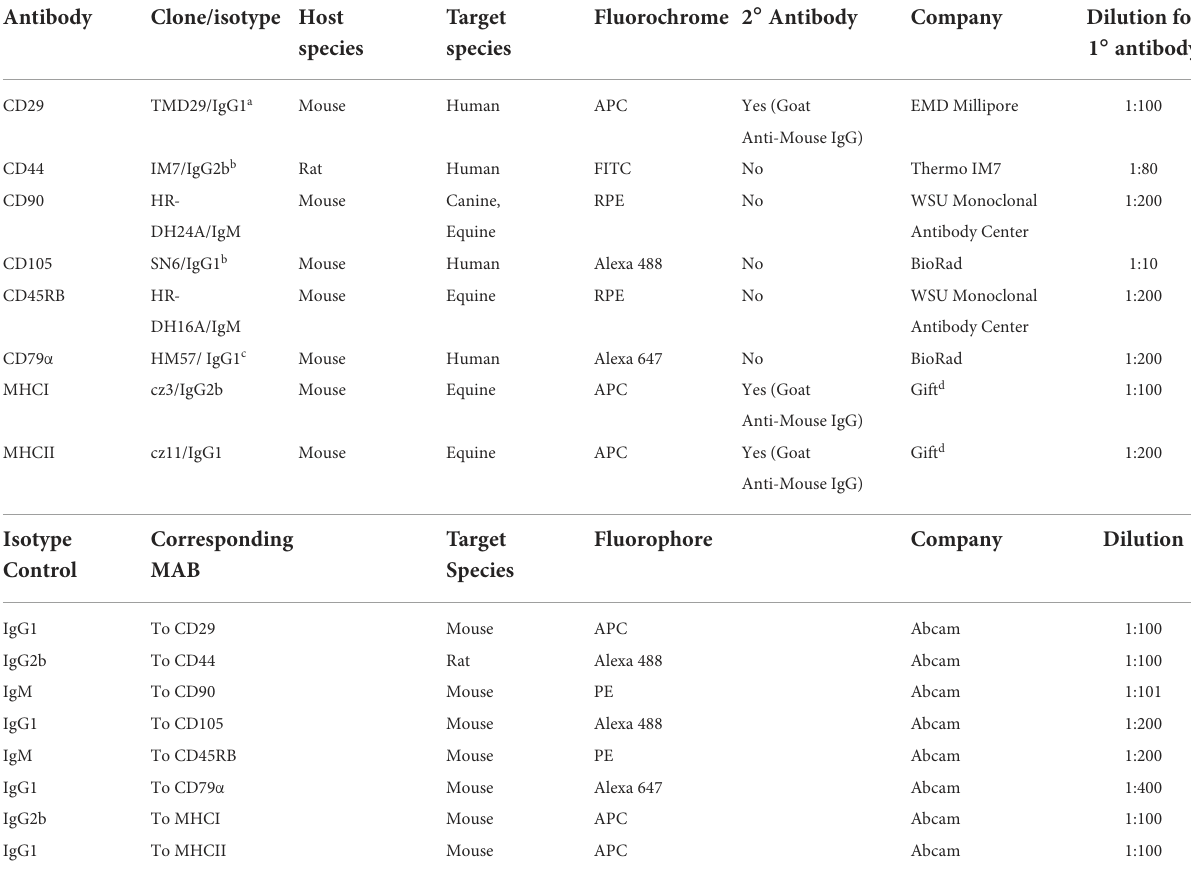
TABLE 1 Antibodies used for flow cytometric analysis of equine cells surface markers.